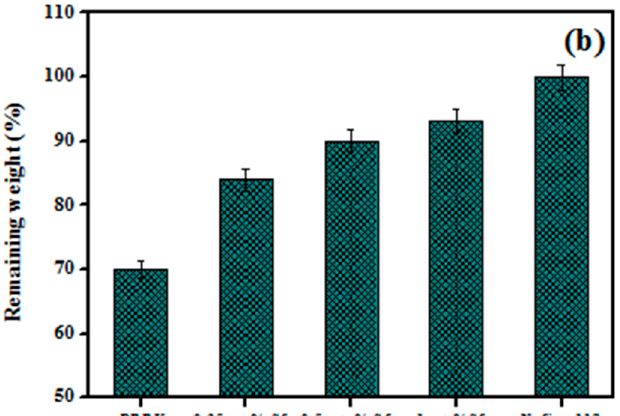
Figure 17. ( a ) DMFC performance representing steady-state cell polarization for Nafion-117, pristine SPEEK and SPEEK-S-fullerene composite membranes at 60 °C and ( b ) oxidative stability for membranes. Reproduced from [76], with permission from Elsevier, 2016.